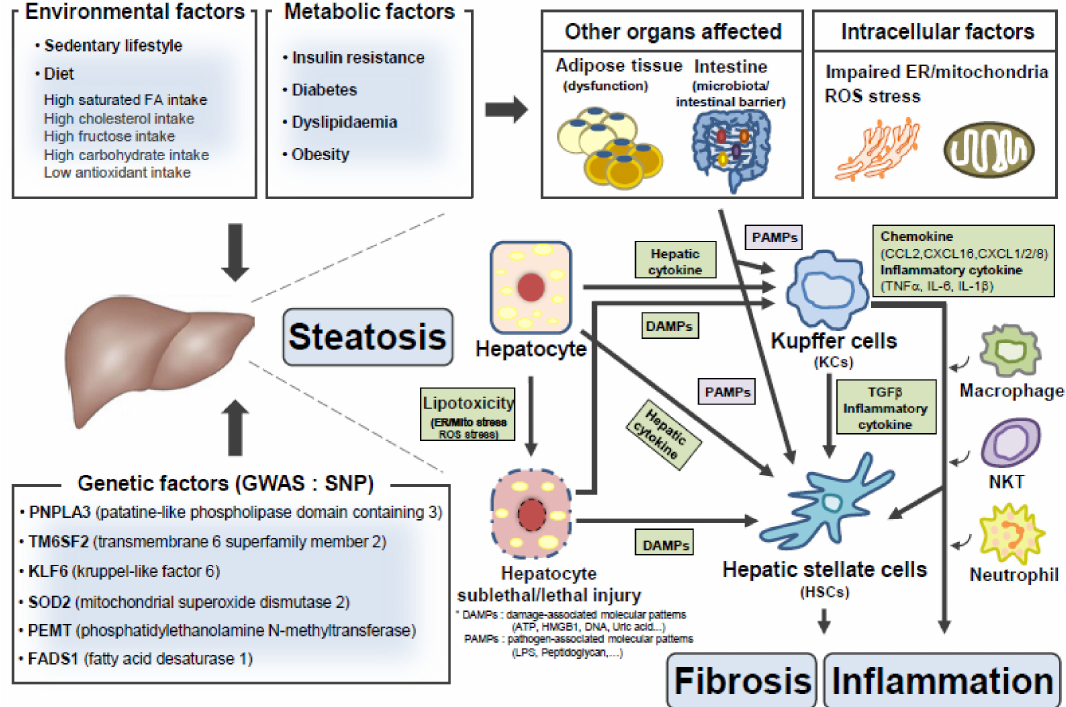
Figure 1. The “multiple-parallel hit” model in the pathogenesis of nonalcoholic steatohepatitis (NASH). Environmental, metabolic, and genetic factors participate in the development of steatosis and the progression to inflammation or fibrosis by a ff ecting diverse cell types (hepatocyte, Kup ff er cell (KC), or hepatic stellate cell (HSC)) in the liver and other tissues (the intestine or adipose tissue). Excess caloric intake (environmental factor) leads to obesity and insulin resistance (metabolic factor) to cause hepatic steatosis. Increased hepatic lipids and / or lipid metabolites cause oxidative or organelle stress, leading to hepatocyte sublethal / lethal injuries. Downstream factors (cytokines / chemokines or damage-associated molecular patterns (DAMPs)) derived from injured hepatocytes stimulate an inflammatory response in KCs and a fibrotic response in HSCs, leading to liver inflammation and fibrosis. Insulin resistance / diabetes and obesity (metabolic factor) also influence organ crosstalk between the liver and other tissues (the intestine / adipose tissue), contributing to the development and progression of